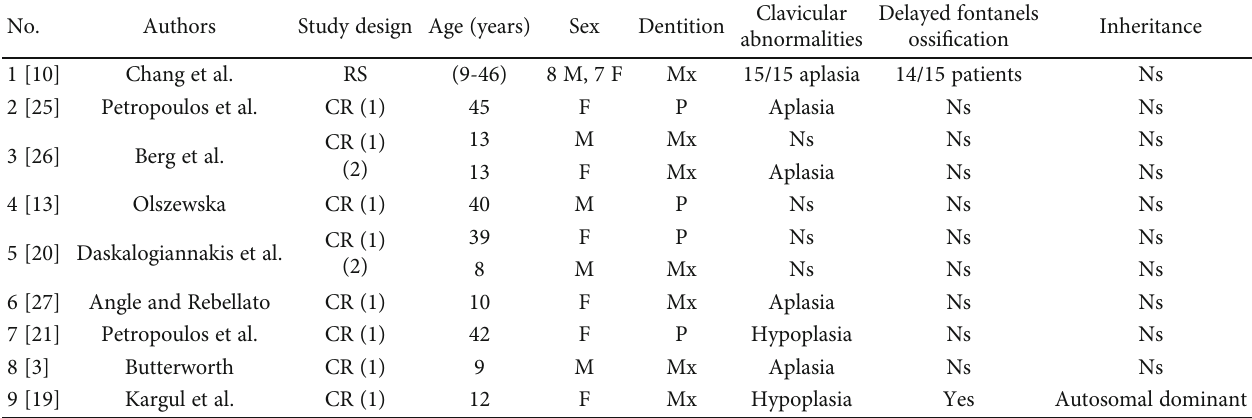
Table 1: Clinical characteristics of the patients included in the systematic